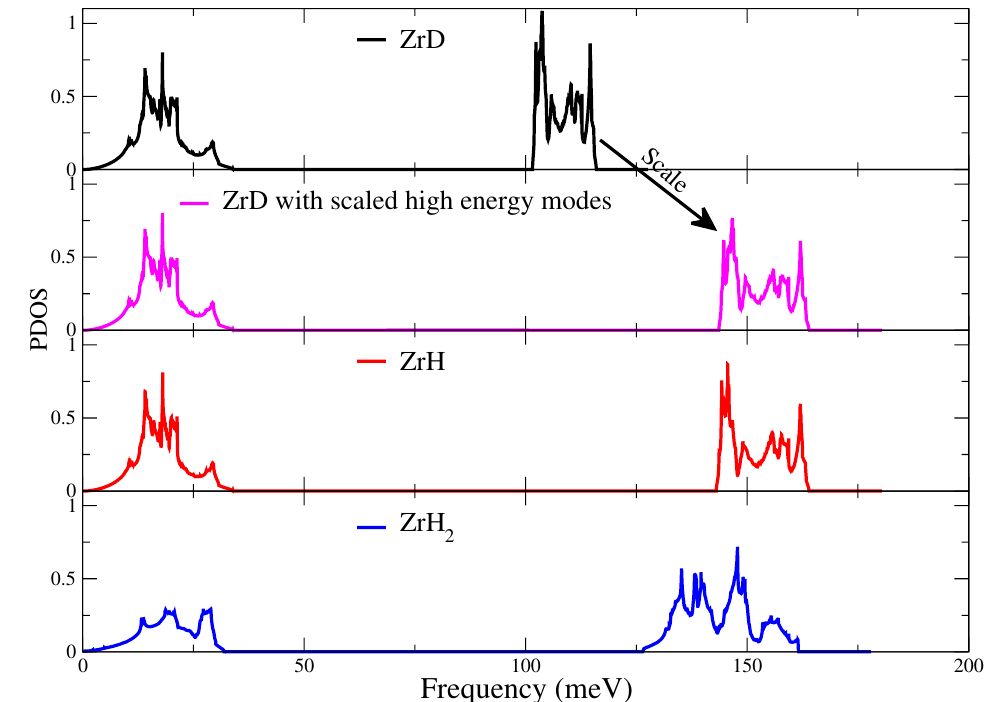
Figure 4. PDOS comparisons between γ -ZrD (black), γ -ZrD with scaled high energy modes (ma- genta), γ -ZrH (red), and (cid:15) -ZrH 2 (blue). The high-energy modes of γ -ZrD are scaled by a factor of in energy, and to keep total DOS unchanged, they are also scaled by 1/ procedure is represented by the black arrow. Low-energy modes are almost identical between γ -ZrH and γ -ZrD, and high-energy modes are nearly identical after